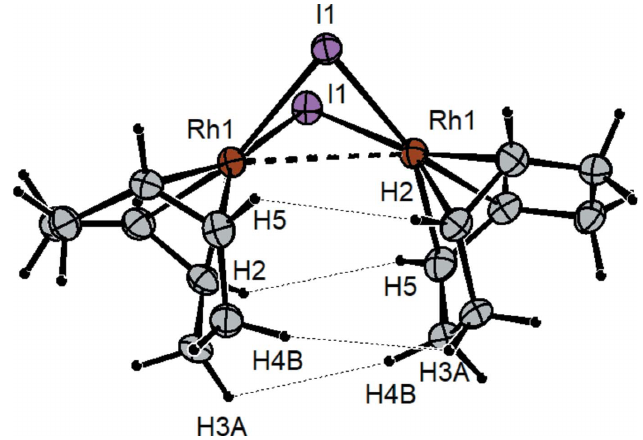
Figure 2 Planar structure of [Rh( (cid:2) -I)(COD)] 2P within the monoclinic P 2 1 / c polymorph. Ellipsoids are drawn at the 50% probability level. Hydrogen atoms are removed for clarity.